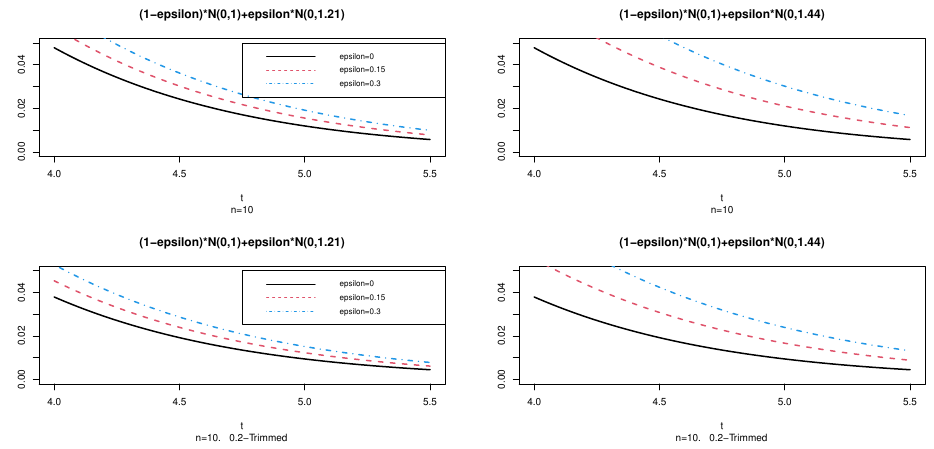
Figure 3. Tail probabilities of the classical method-of-moments cross-variogram estimator 2 (cid:99) γ ij ( h ) (top row of figures) and 0.2-trimmed cross-variogram estimator 2 (cid:99) γ ij with no contamination, (cid:101) = 0, and contaminations (cid:101) = 0.15 and (cid:101) =